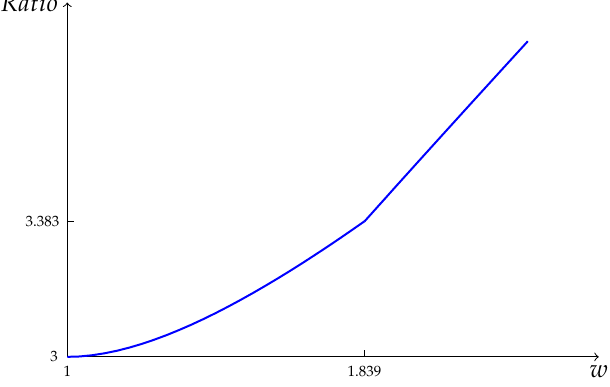
Figure 1. Two competitive ratios in this